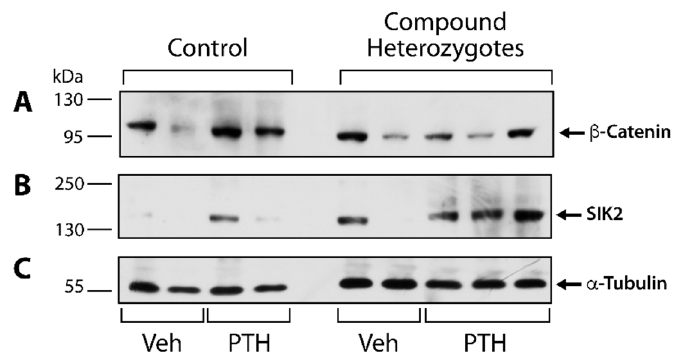
Figure 6. Parallel PTH signaling pathways in control ( Naca 99S/S ; Lrp6 +/+ ;OCN ‐ Cre) and compound heterozygous ( Naca 99S/A ; Lrp6 +/fl ;OCN-Cre) littermates. Protein extracts were prepared from tibial shafts and immunoprobed for β -Catenin ( A ) and SIK2 ( B ). Equivalent loading was assessed by probing for α‐ Tubulin ( C ).